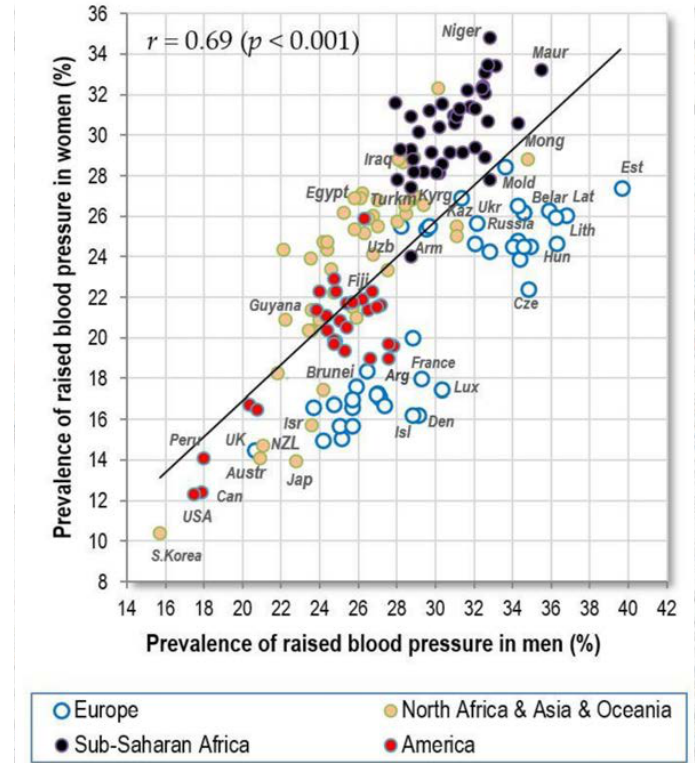
Figure 1. Relationship between the prevalence of men‘s and women’s raised blood pressure (%; WHO, 2010).